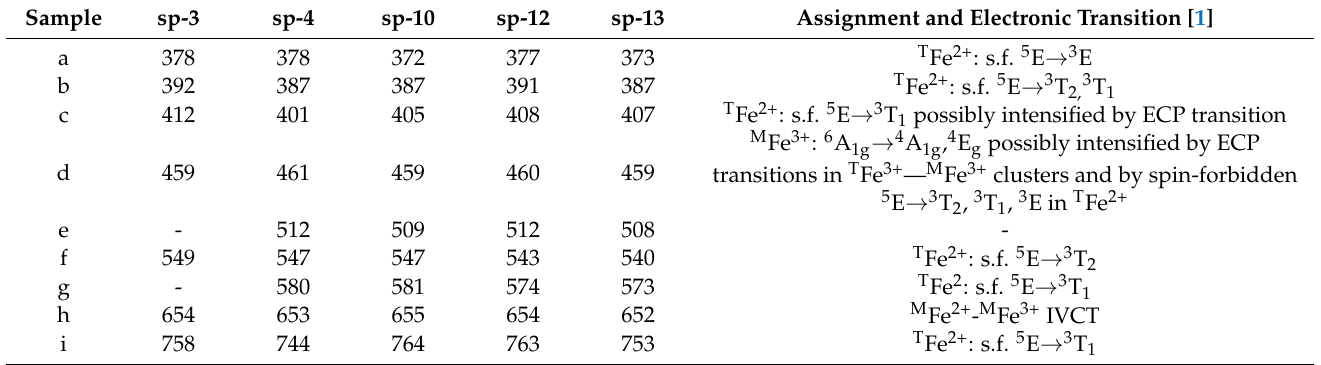
Figure 8. UV-Vis absorption spectra split peak fitting of sp-12. Table 4. Iron-bearing spinel UV-vis absorption spectrum assignment and electronic transition (nm).